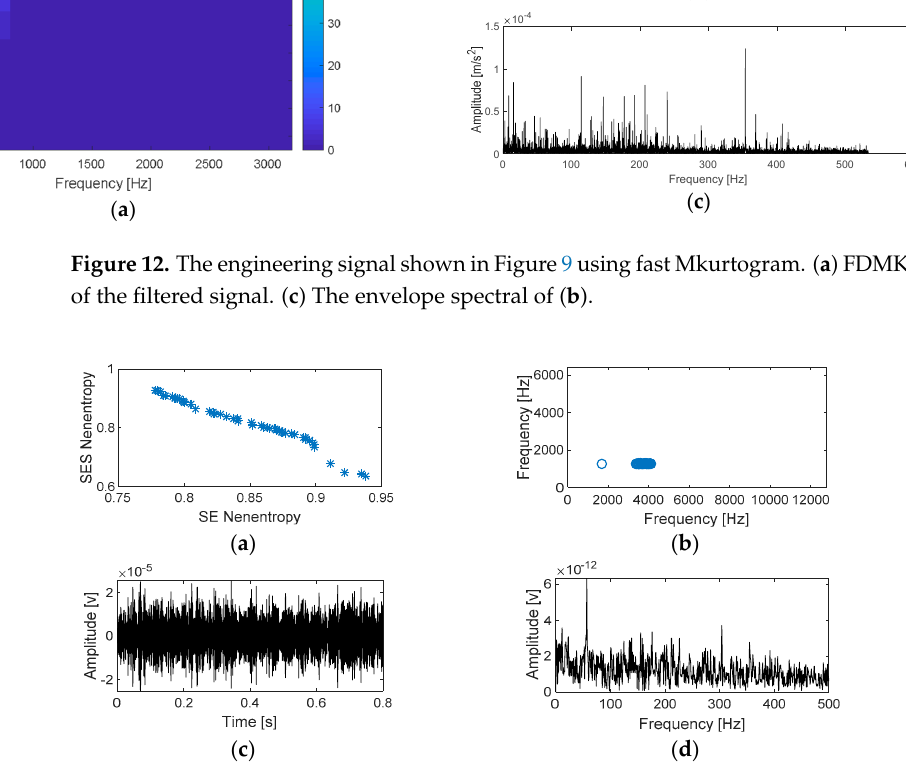
Figure 13. The experimental signal shown in Figure 7a using the proposed method in [48]. ( a ) Pareto front. ( b ) Distribution of the Pareto set. ( c ) Filtered signal. ( d ) The envelope spectral of ( c